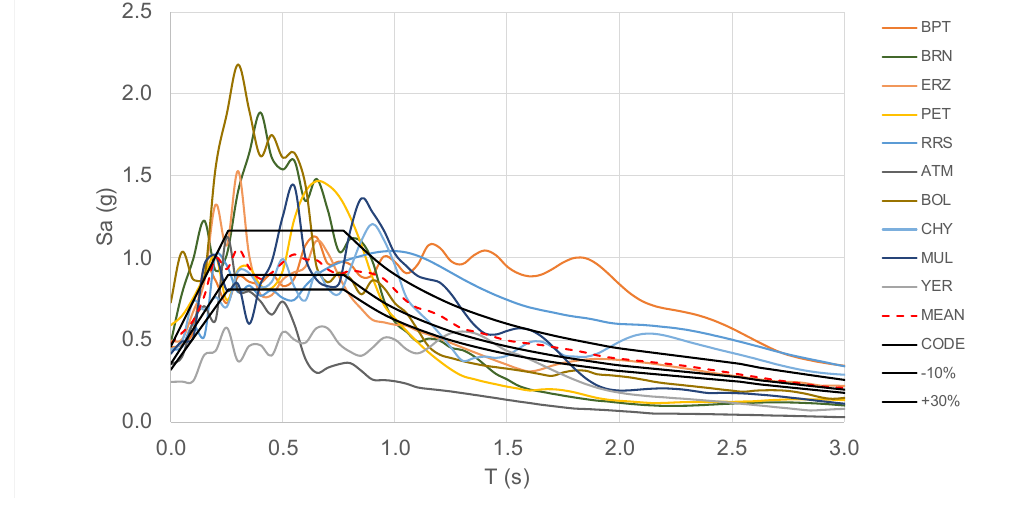
Figure 8. Selected input motions. Table 8. Input motions characteristics.